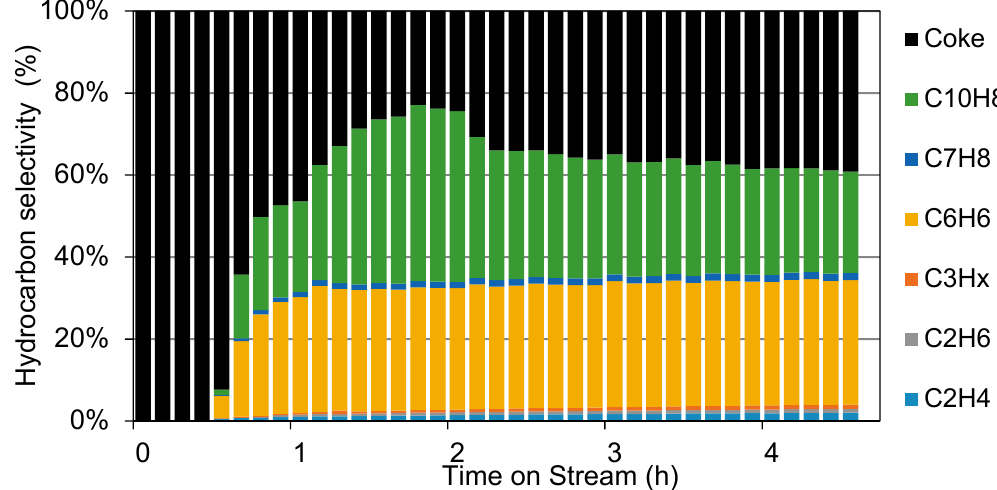
Figure 8. Experimental hydrocarbon selectivities for the catalytic sample 6 wt. % Mo/ZSM-5 prepared with ultrasound.